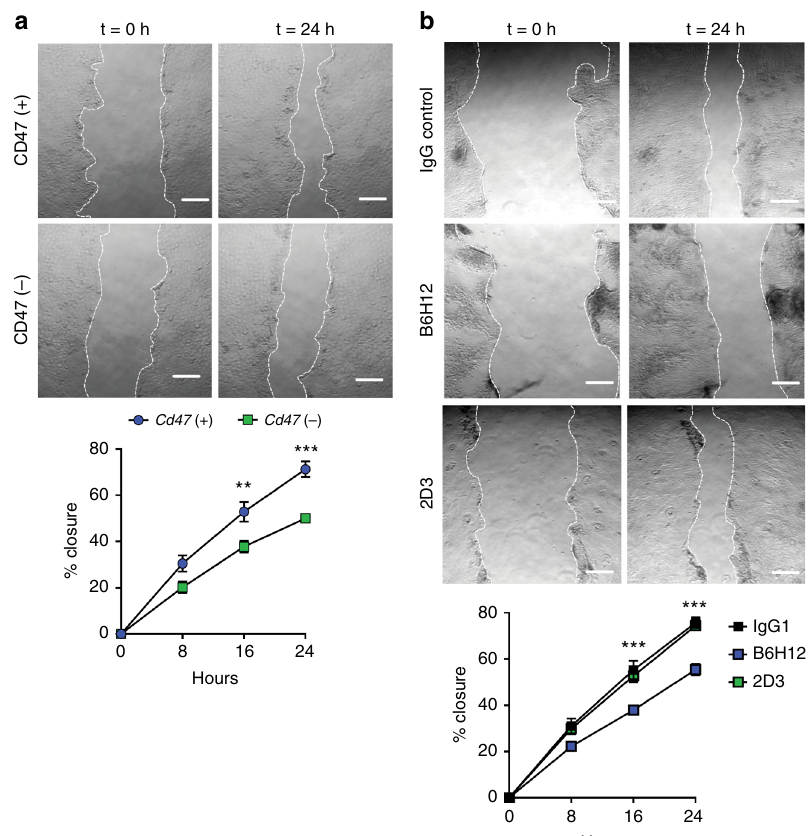
Fig. 5 CD47 is required for wound repair in cultures of primary epithelial monolayers. a Primary epithelial cell monolayers derived from CD47-expressing (CD47( + )) or CD47-de fi cient (CD47( − )) murine enteroids were scratch-wounded and monitored for closure. CD47( − ) epithelial monolayers showed signi fi cant impairment in reduction of scratch-wound surface area at 24 h post scratch. Edges of scratch wounds are indicated by dashed lines. Scale bars = 50 μ m. b Primary epithelial cell monolayers derived from human stem cell-derived colonoids were scratch-wounded and treated with 10 µ g/ml of either IgG control antibody, function-blocking anti-CD47 antibody (clone B6H12), or non-blocking anti-CD47 antibody (clone 2D3), resulting in the inhibition of cell migration upon blockade of CD47. a – b Results are representative of three independent experiments with three replicates per treatment group. Data are means ± SEM. Signi fi cance determined by two-way ANOVA, ** p ≤ 0.01, *** p ≤ 0.001. Source data are provided as a Source Data fi